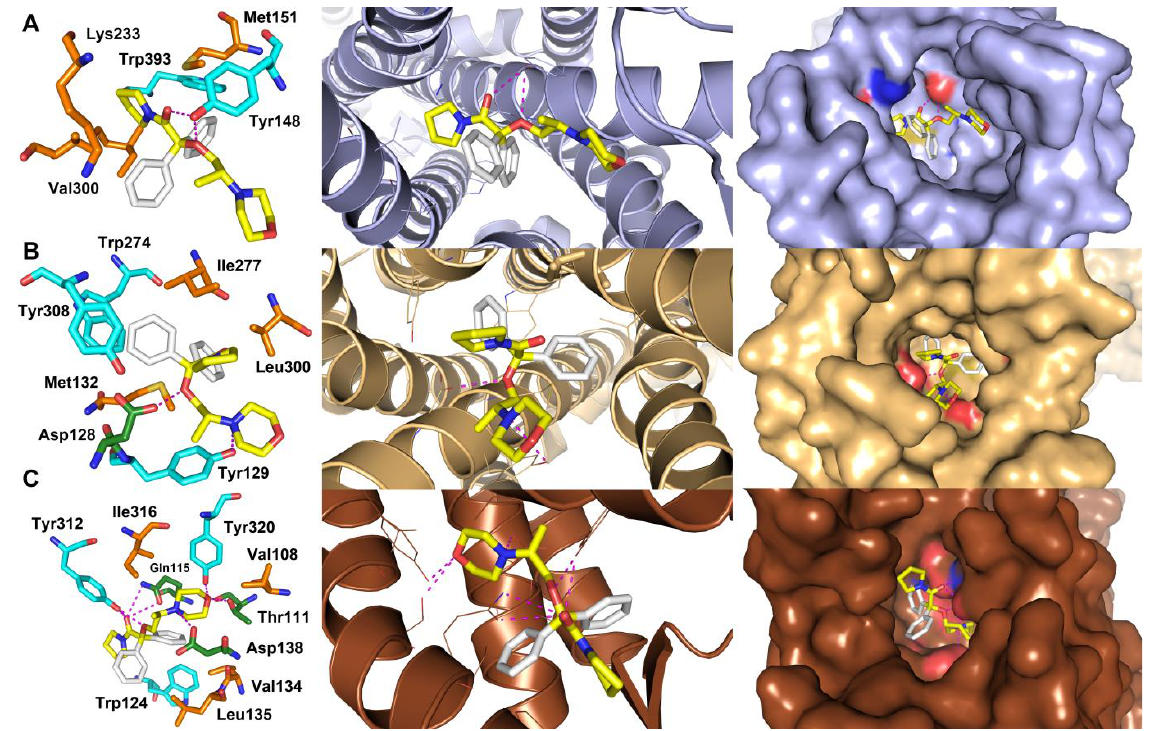
Figure 3. Representative binding modes for the lowest binding-energy complexes of ethereal analog of iso -moramide ( R )-(–)- 10 (yellow-white sticks) with ( A ) µ -type opioid receptor (PDB ID: 4DKL) ( B ) δ -type opioid receptor (PDB ID: 4EJ4) and ( C ) κ -type opioid receptor (PDB ID: 4DJH). The most significant amino acid residues contributing to the stabilization of the ligand molecules in the complexes with all three types of ORs are shown in sticks representations (left column); the key amino acids responsible for polar interactions, including hydrogen bonding, are shown in cyan or green (which in addition indicates the closest H-bonding); for CH–CH van der Waals (vdW) interactions are shown in dark orange. The overall receptor structures are shown as a cartoon diagram (middle column) or surface representation (right column), where µ -OR is light blue, δ -OR is gold, and κ -OR is brown, respectively. Nitrogen atoms are highlighted in blue, oxygen atoms in red, and sulfur in dark yellow. The formation of intermolecular hydrogen bonds is represented by magenta dashed lines. For clarity, H atoms are omitted.